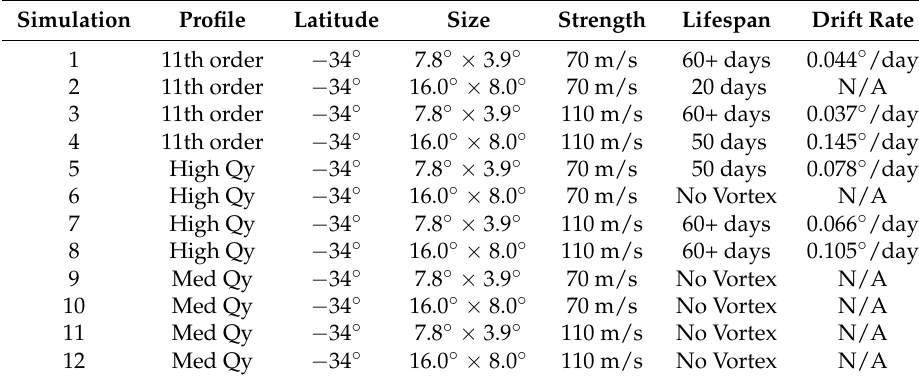
Table 2. Results of initial set of dry